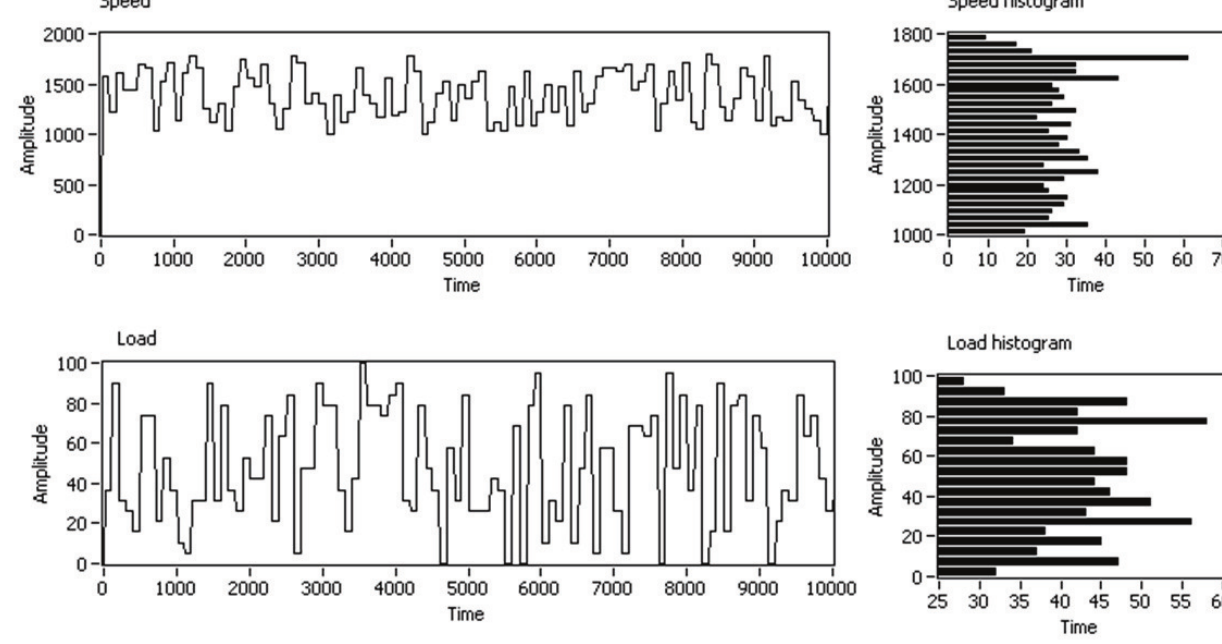
Figure 3. Example of random profiles of speed and load applied to the